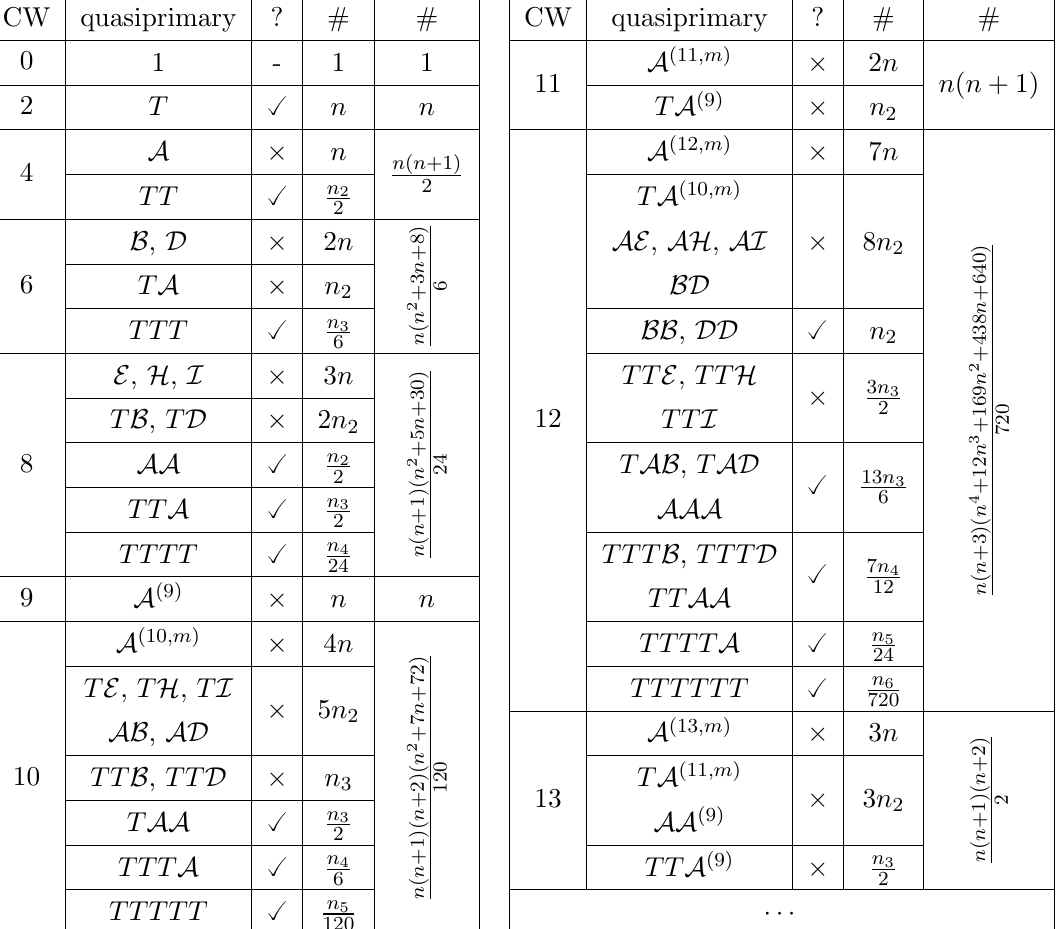
T j A j with 0 (cid:20) j 1 ; 2 ; 3 (cid:20) n (cid:0) 1, j 1 < j 2 , 1 2 3 for nonidentity operators with generally non- (cid:8)